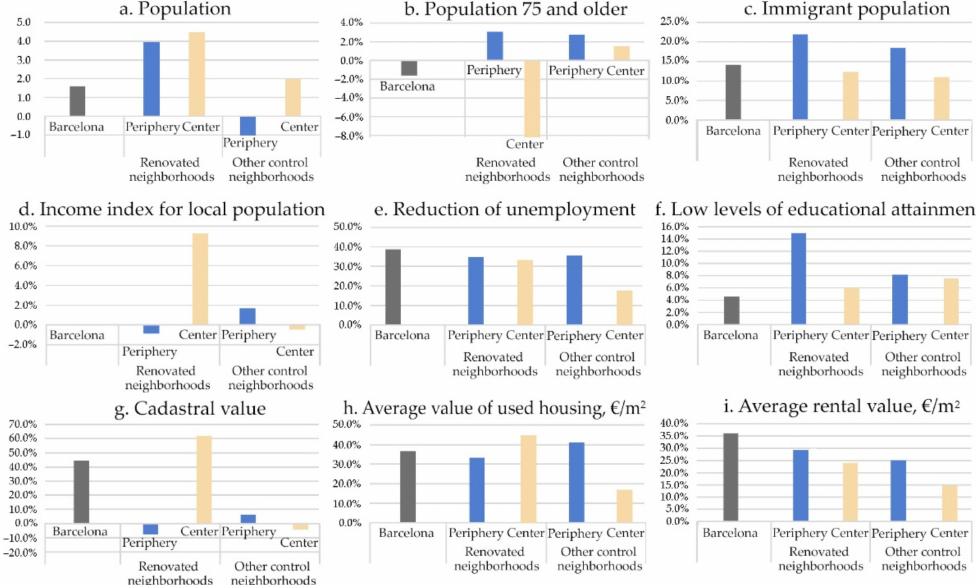
Figure 7. Evolution of population, income, and urban values, 2013–2019. Source: created by the author using data from the Department of Statistics of the Barcelona City